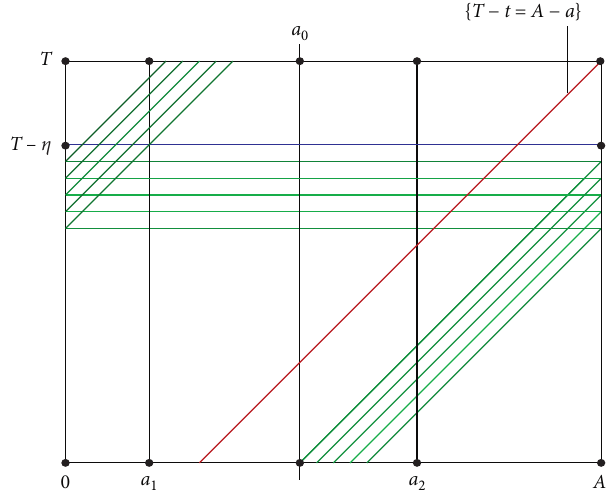
, A ) (green lines) hits the line ( a � A ) , gets renewed by the renewal 2 of the pair ( A , B ) , the 0 time to hit the line a � A , get renewed by the renewal condition β ( a ) q ( 0 ,t ) , and take 2 + a + 2 T time to obtain the observability 2 1 0 + a + 2 T + T , A ) , T > 􏽢 T , and a < η < T , all the characteristics starting at ( a, 0 ) with a ∈ ( a 2 1 0 0 1 0 2